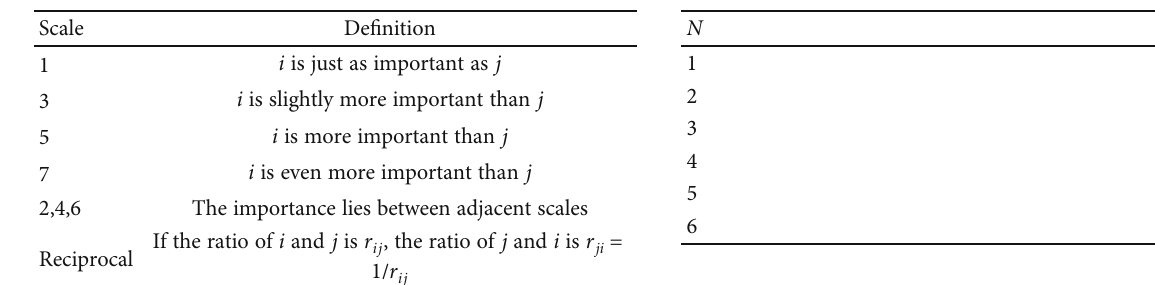
Table 4: Scale de fi nitions of 1-7 scale method. Table 5: The standard consistency